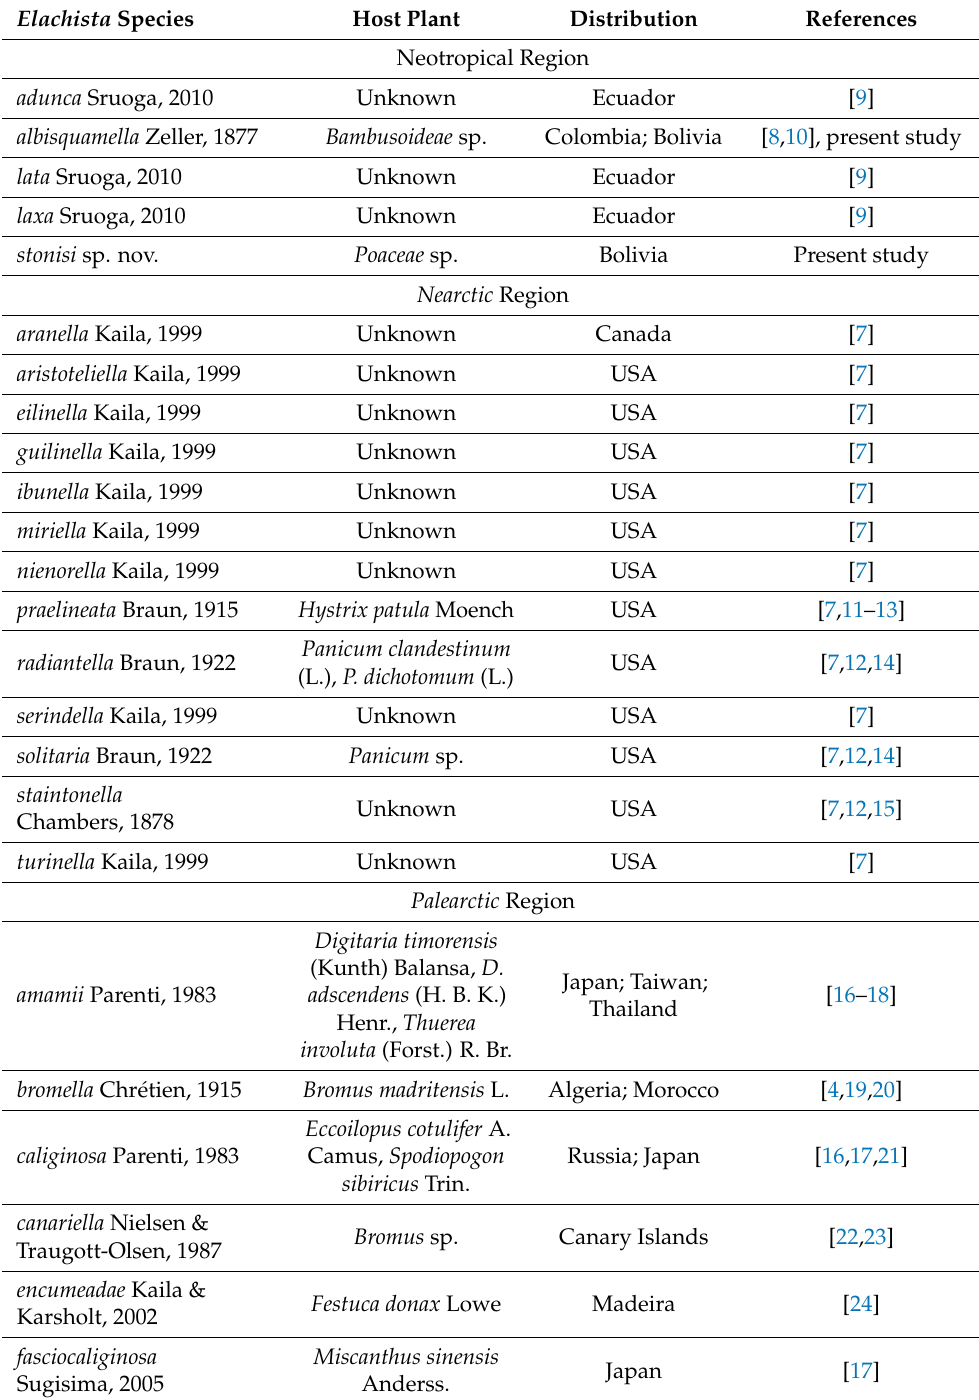
Table 1. Species, distribution, and host plants of the Elachista praelineata species